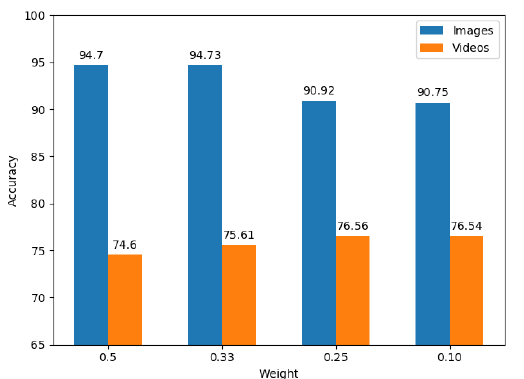
Figure 5. Test accuracy of the multitask learner on images and video I-frames obtained by fixing w V = 1 and varying the images weight w I according to Equation (1).